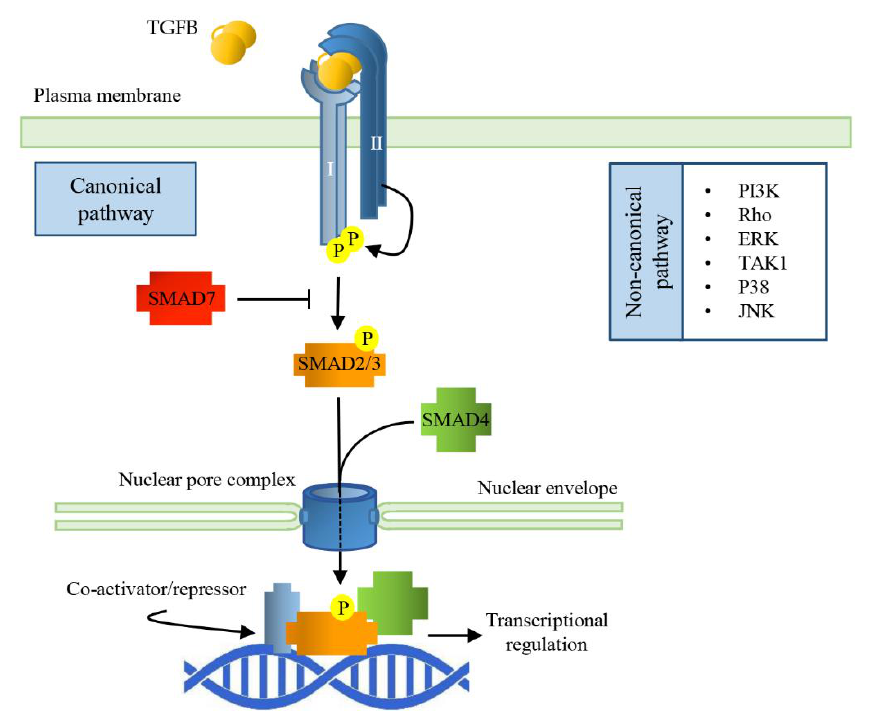
Figure 1. Signal Transduction pathways of TGFBs. TGFB dimerization triggers the assembly of a heterodimeric complex between Type I and Type II receptors (TGFBRI and TGFBRII). This permits TGFBRII to trans-phosphorylate TGFBRI that, in turn, activates the receptor-regulated SMADs (SMAD2 / 3) by phosphorylation. Activated R-SMAD forms a complex with the common SMAD (SMAD4) and together translocate into the nucleus through nucleoporins; the complex interacts with specific SMAD binding elements (SBEs), regulating gene transcriptional responses.